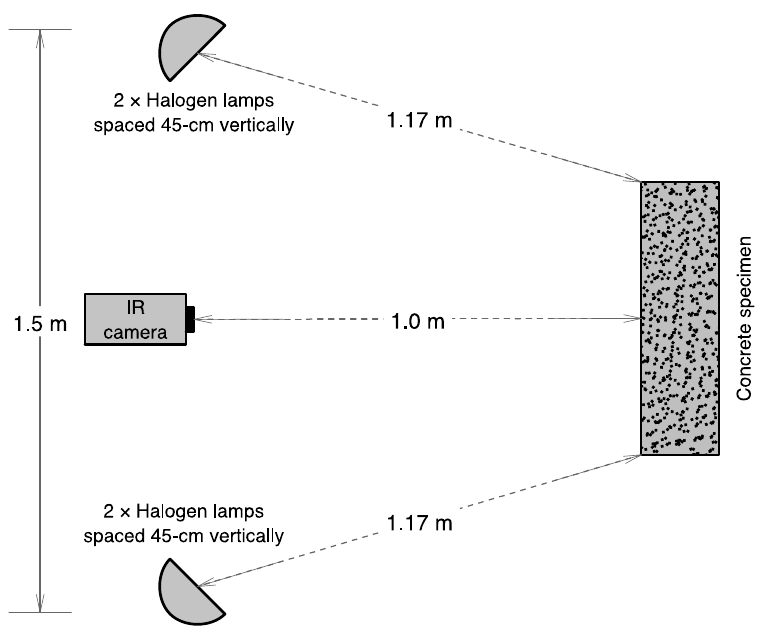
Figure 5. Schematic diagram of the thermographic setup.